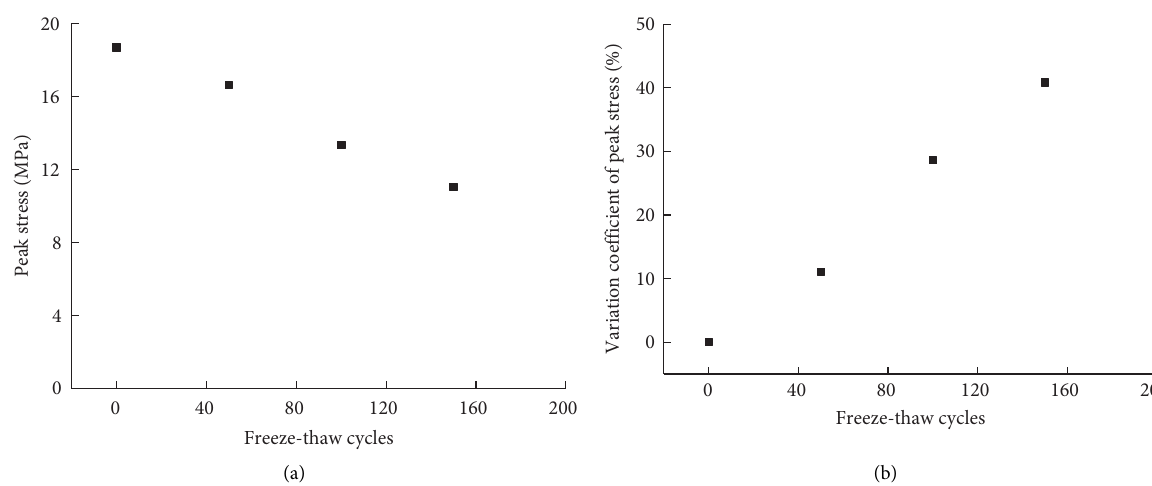
Figure 5: The effect of the number of freeze-thaw cycles on the peak stress of rubber concrete. (a) Peak stress. (b) Peak stress variation